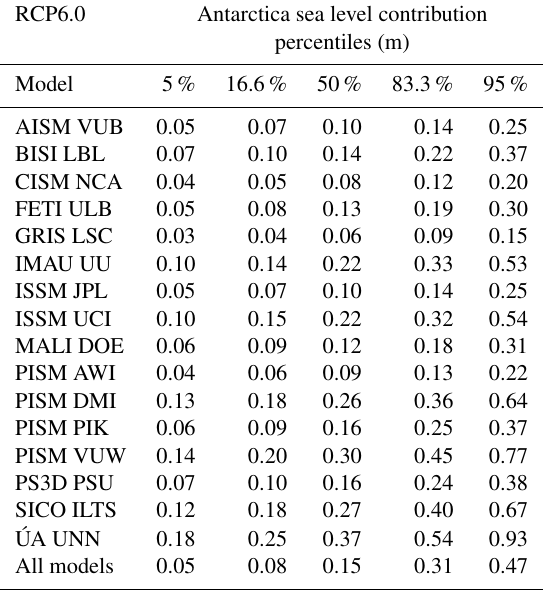
Table 9. Percentiles of the probability distribution of the sea level contribution of Antarctica for different ice sheet models under the RCP6.0 climate scenario. The 50th percentile corresponds to the median; 16.6%–83.3% is the so-called “likely range” as denoted in the IPCC reports. The “very likely range” is given by the 5th–95th percentiles.